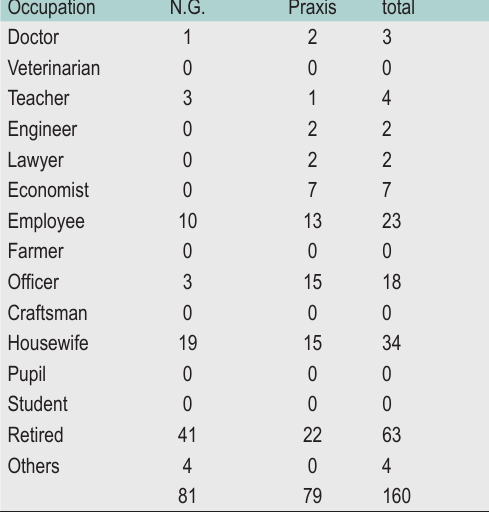
TABLE 3. Presentation of respondents with bilateral gonar- throsis by occupations in clinics D.Z. “Novi Grad”,"Praxis" and